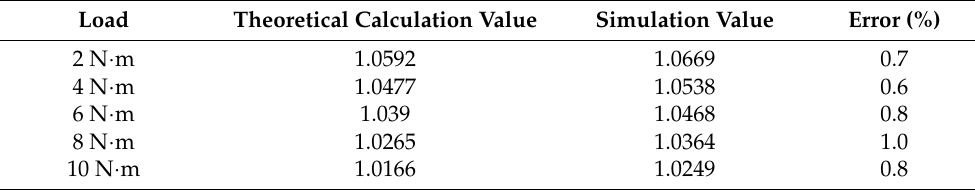
Table 3. Average value comparison of load proportional coefficient under different loads.